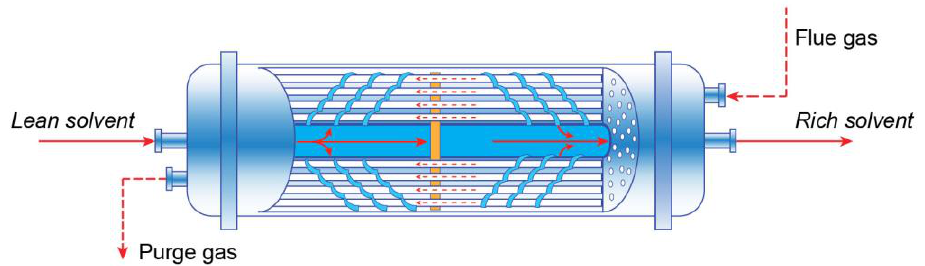
Figure 9. Schematic description of mass transfer in hollow fiber membrane contactors (Adapted from [90]).